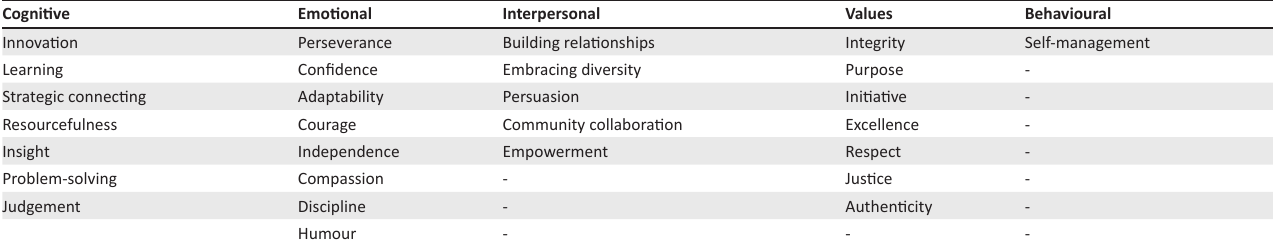
TABLE 2: Overview of psychological strengths of Muslim women